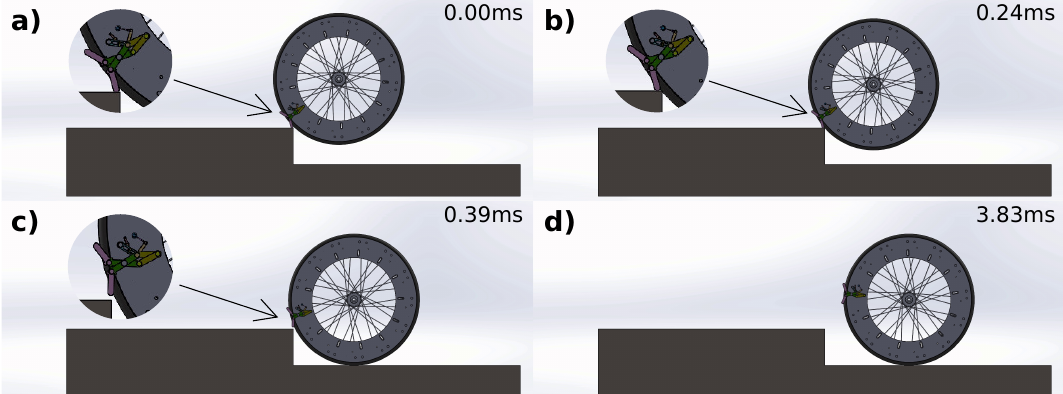
Figure 21. Motion simulation of the mechanism while descending a step (time stamp in milliseconds is roughly estimated from videos) ( a ) the wheel starts to roll with tip of link 2 as a pivot; ( b ) as the wheel rolls down, the tip of link 2 touches the edge of the step preventing the wheel from slipping; ( c ) descending of wheel is complete; ( d ) wheel moves forward in plane after completion of